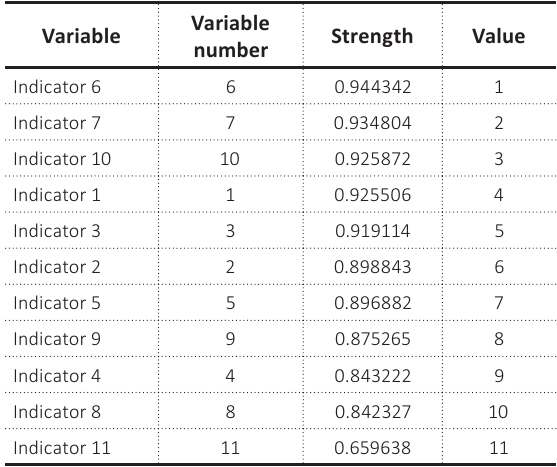
Table 3. Determining the rank of direct